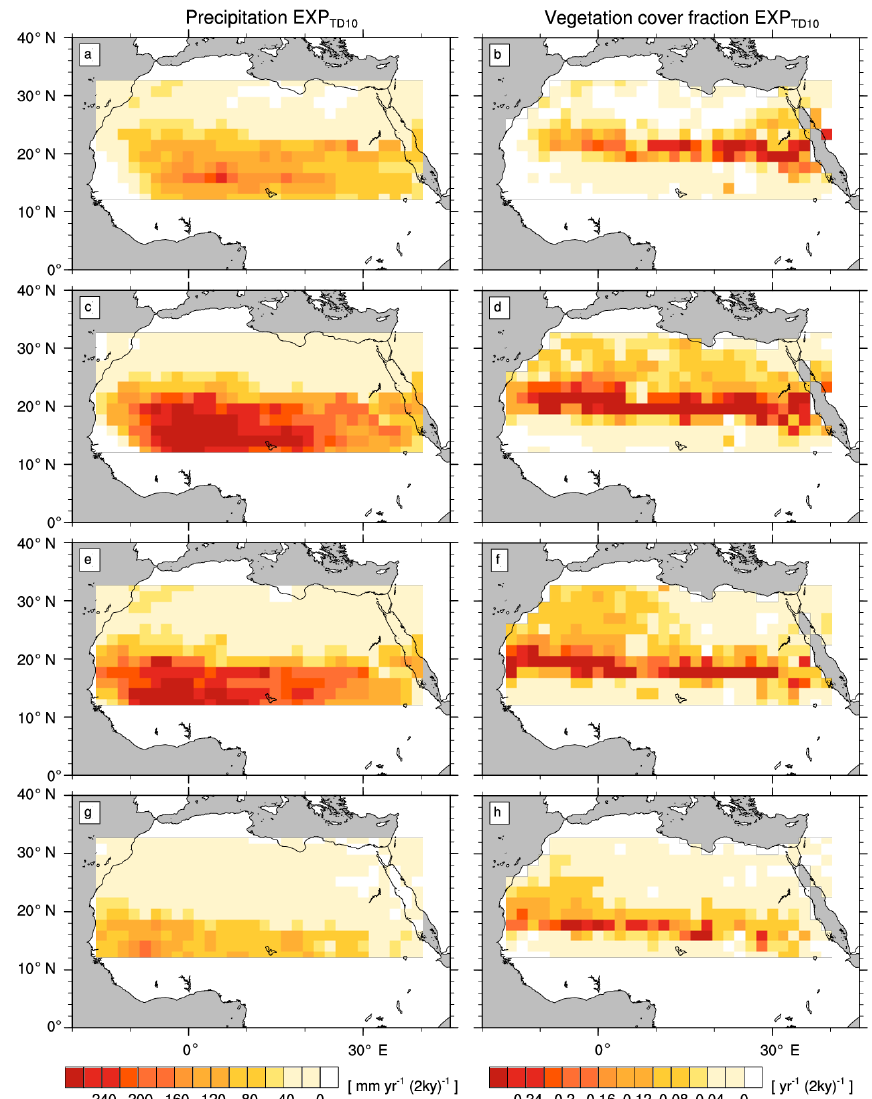
Figure A4. Transition rates from the green Sahara to the desert state for precipitation P (left column) and vegetation cover fraction veg max (right column) of a simulation with the standard PFT set and a newly designed frost-tolerant tropical deciduous tree PFT (EXP TD depict differences between consecutive time slices (100-year averages): 6–8kyr (a, b) , 4–6kyr (c, d) , 2–4kyr (e, f) , and 0–2kyr (g, h)